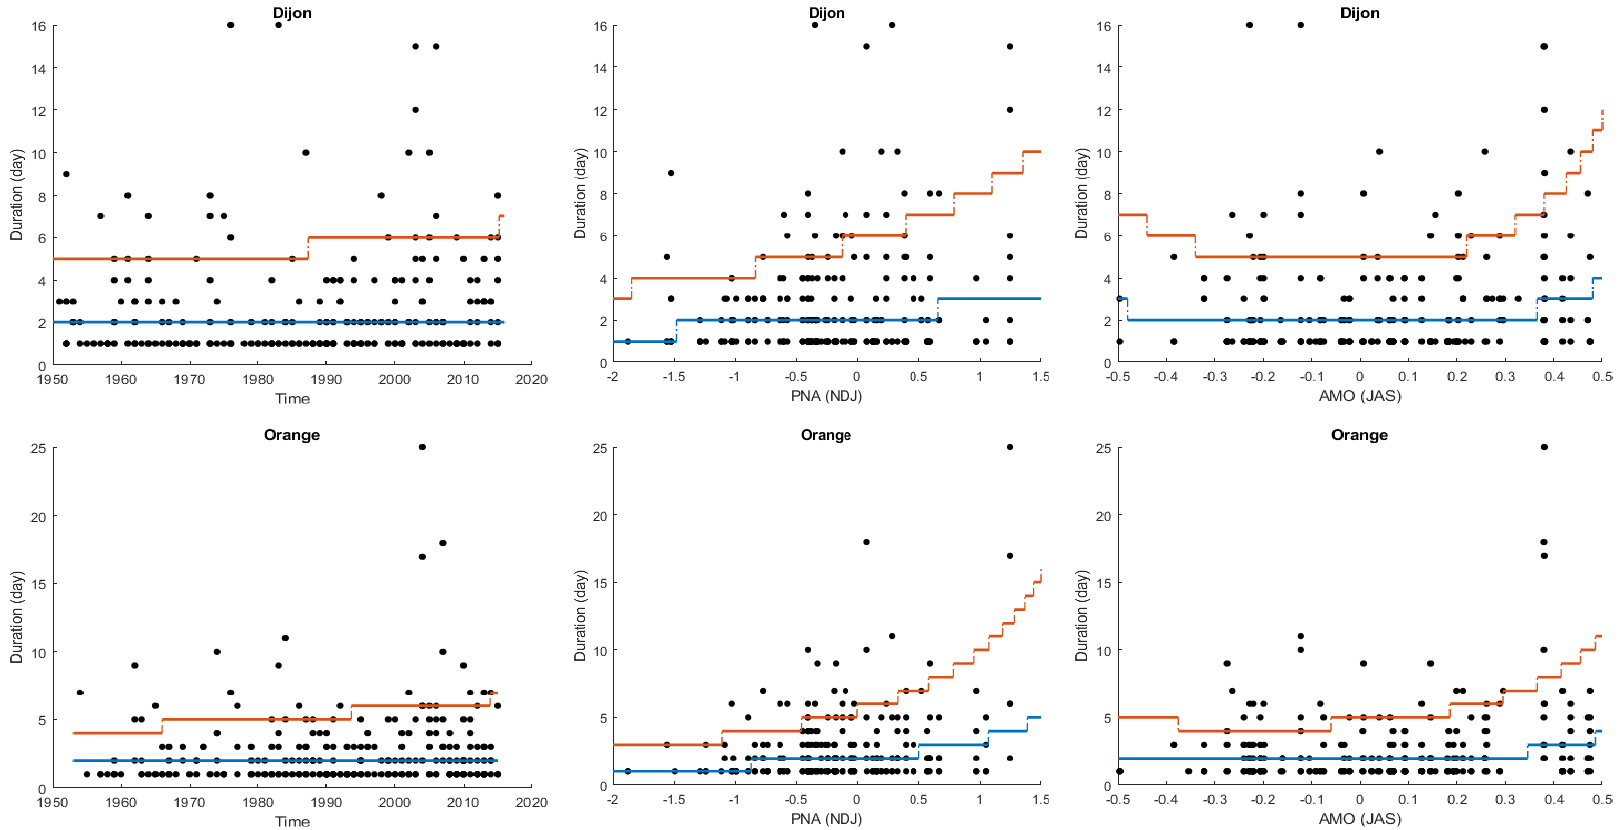
Figure 8. Duration quantiles corresponding to the non-exceedance probabilities p = 0.5 (blue line) and 0.9 (red line) as a function of each covariate.